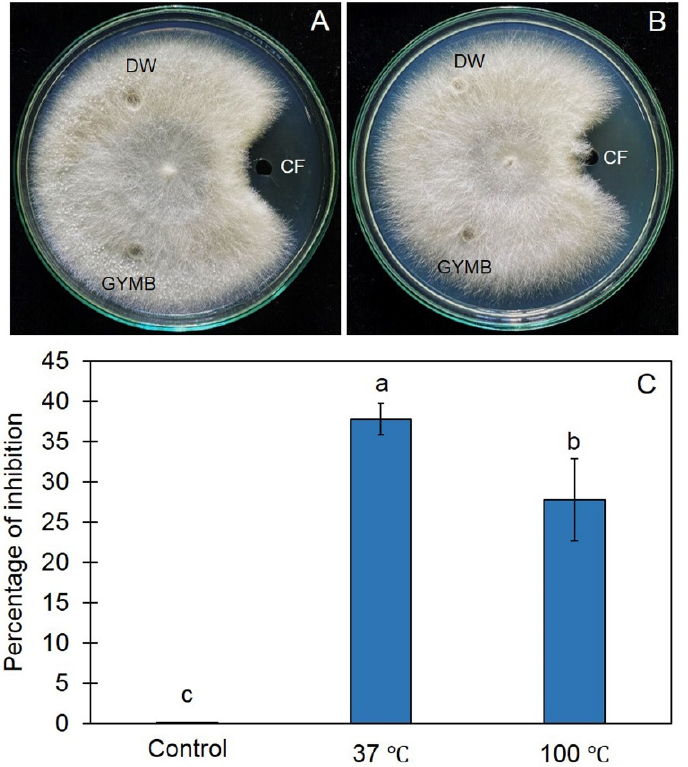
Figure 3. Effect of temperature on the antifungal ability of the cell-free culture filtrate (CF) incubated at 37 °C ( A ), 100 °C ( B ), and the percentage inhibition of the cell-free CF ( C ). Different letters indicate significant differences according to Tukey’s test ( p < 0.05).